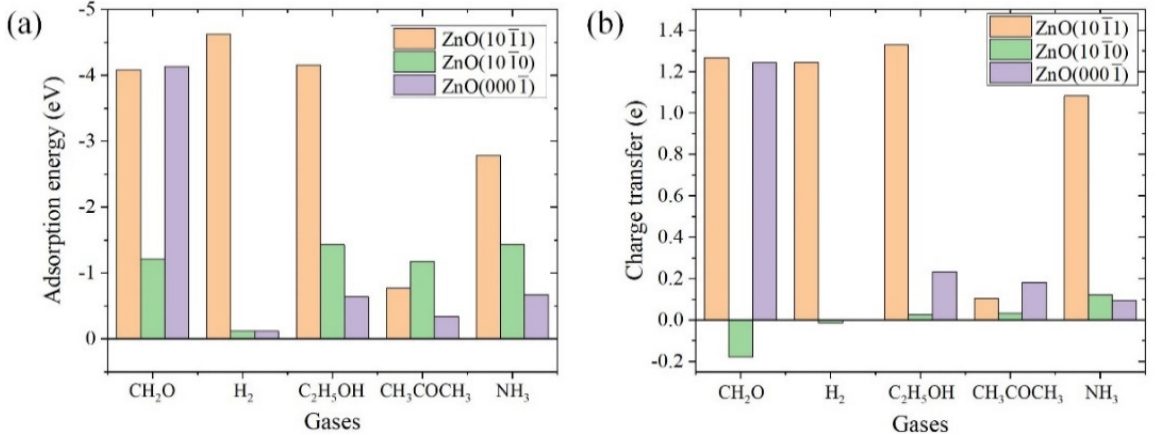
Figure 3. Adsorption energies ( a ) and charge transfers ( b ) of the adsorption